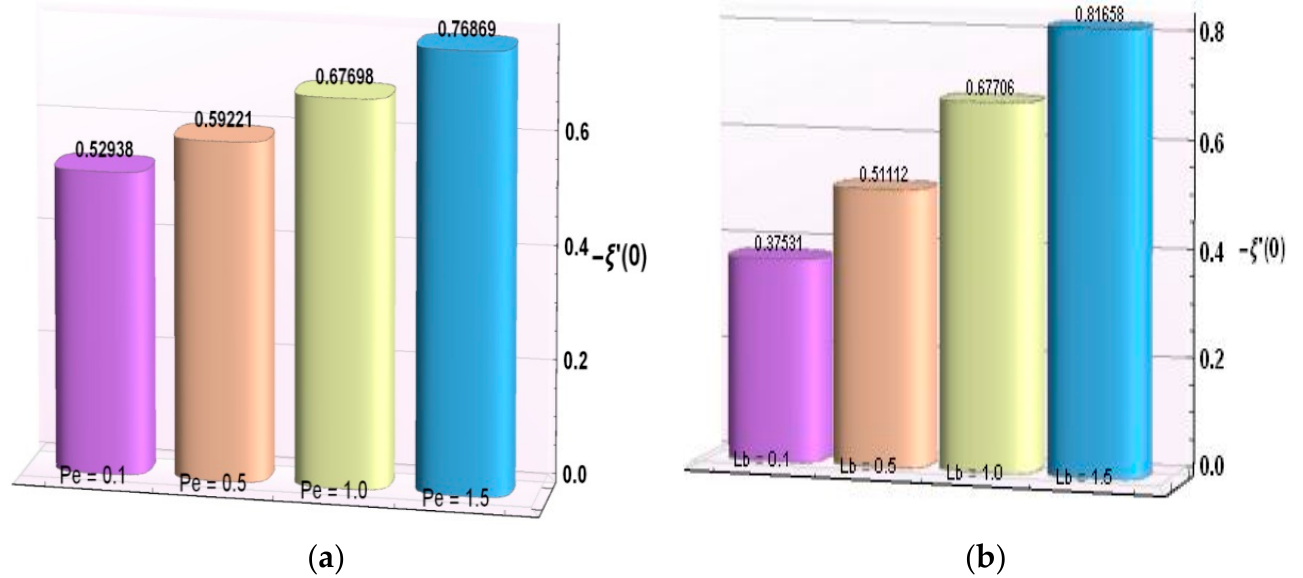
Figure 7. Behavior of ( a ) − ξ (cid:48) ( 0 ) for Pe and (b) − ξ (cid:48) ( 0 ) for